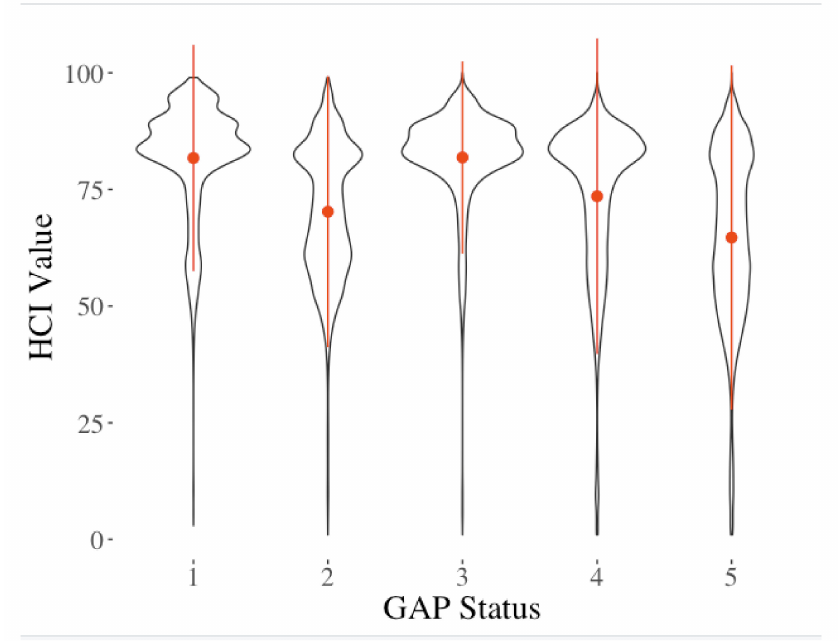
Figure 8. Distribution of Habitat Condition Index (HCI) values by GAP status. Note that GAP 5 was created for this analysis and includes private working lands (i.e., lands used for grazing or silviculture). Functional Forest working (Gap 3–5) and non-working (Gap 1–2) habitat broken